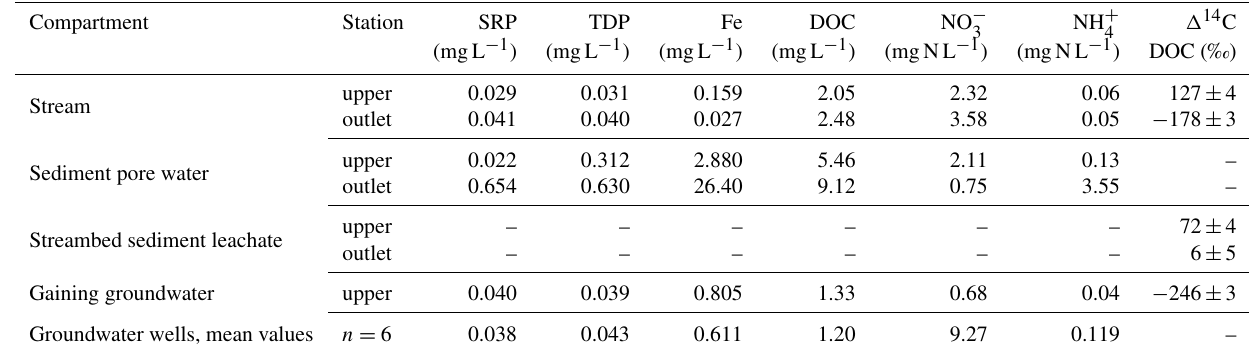
Table 1. Concentration of SRP, TDP, Fe, DOC, NO − compartments and in groundwater wells; September 2020 sampling